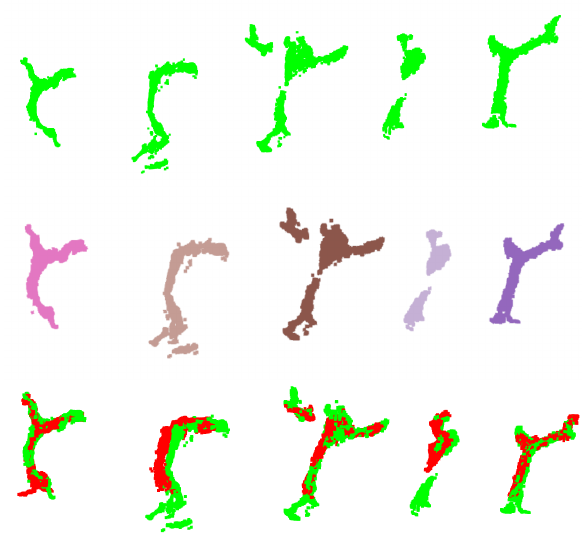
Figure 6: Details of 2D/3D object extraction method.